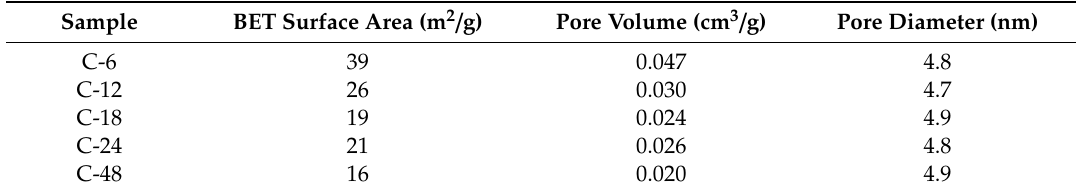
Table 1. Surface area and pore-size distribution parameters of CdS NR samples.